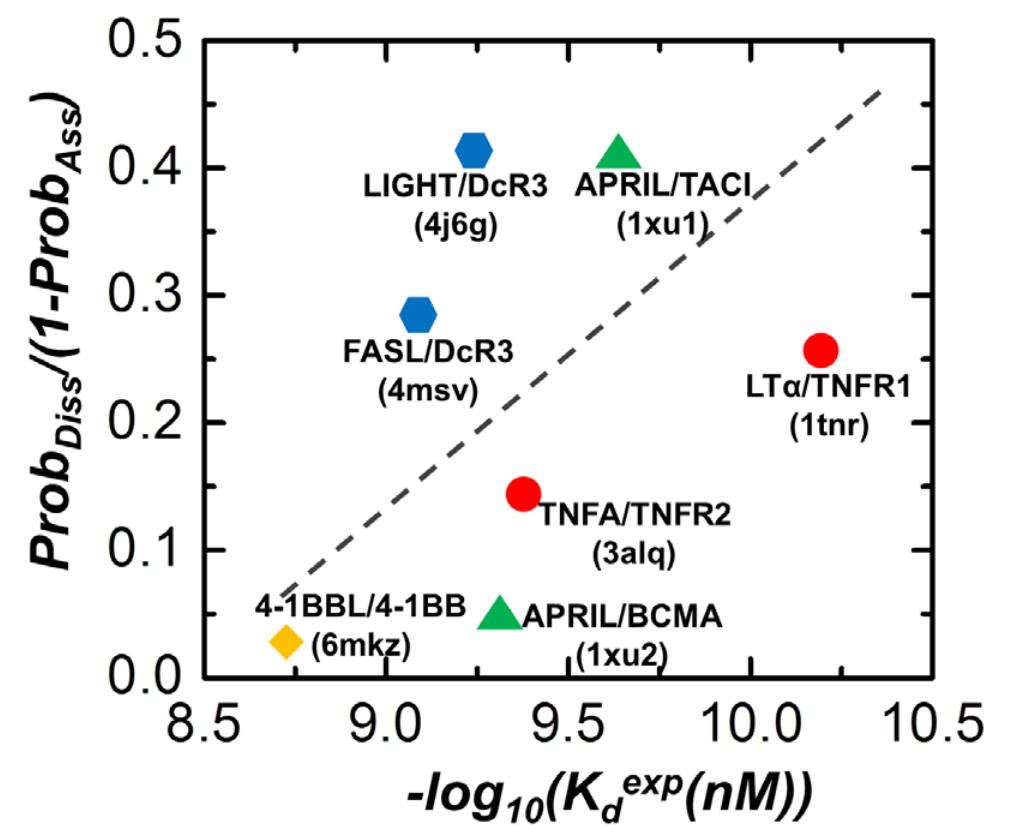
Figure 5. Among 10 protein complexes in the dataset, 7 of them had corresponding data of binding affinities available in the literature. In order to compare our simulation results with the available experimental measurements, the calculated probabilities of association and dissociation from our simulations were combined together and converted into a stability factor, which was positively correlated with the binding strength. As a result, the calculated stability factors for these seven complexes were directly correlated to the logarithm of their experimentally measured binding affinities. As shown by different symbols in the figure, the seven protein complexes were further divided into different subgroups, so that they could be compared within the specific biological context.